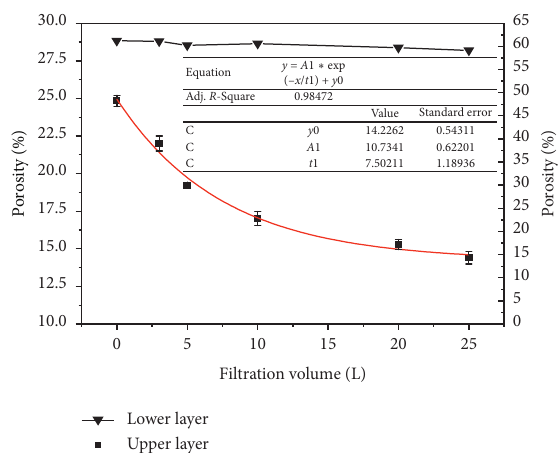
Figure 6: The porosity change of the upper layer and lower layer with filtration